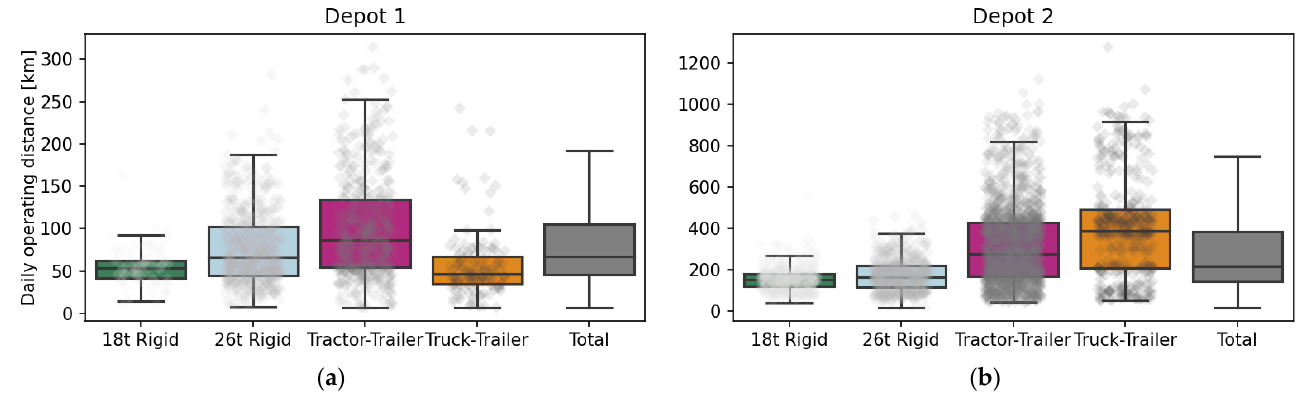
Figure 2. Evaluation of daily operating distances per truck class; ( a ) Depot1; ( b ) Depot2; Sample points are scattered. Boxplots include the lower quartile, median, upper quartile, and whiskers (±1.5 IQR); Colors indicate different truck classes: 18-t rigid (green), 26-t rigid (blue), tractor-trailers (purple), truck-trailers (orange), and total (grey)—own illustration.